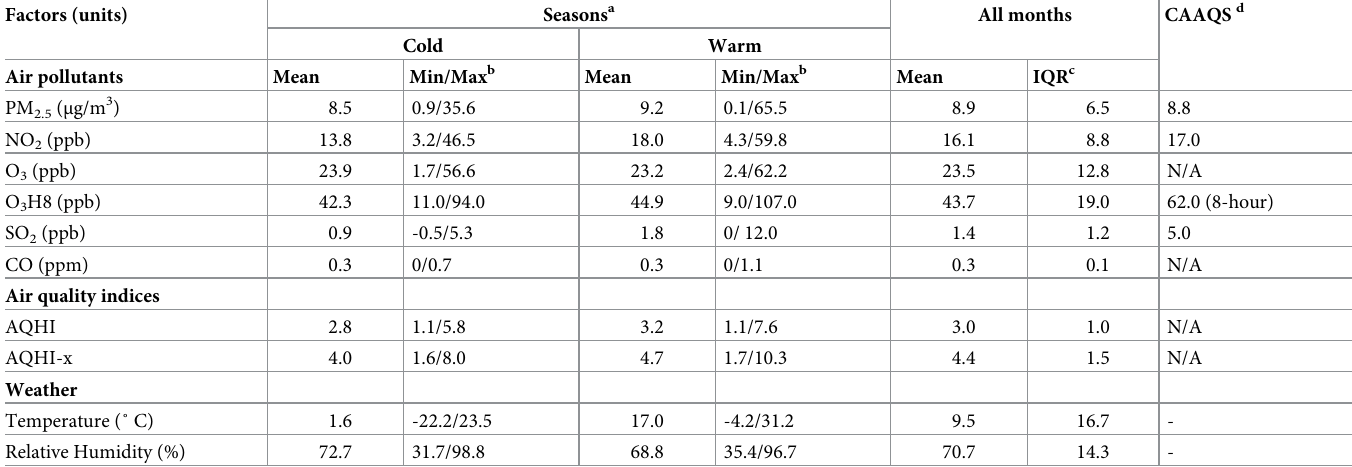
Table 3. Descriptive data on ambient air pollutants and meteorological conditions on a daily basis, collected in Toronto, Canada between April 1, 2004 and Decem- ber 31, 2015. Factors